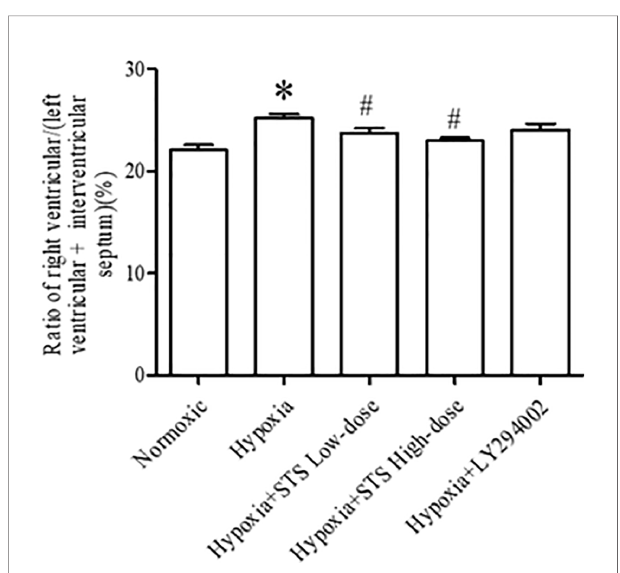
FIGURE 1 | Mean pulmonary artery pressure in rats. Data are presented as mean ± SEM (n = 10). * P < 0.05 compared with normoxia group, # P < 0.05, compared with hypoxia group.